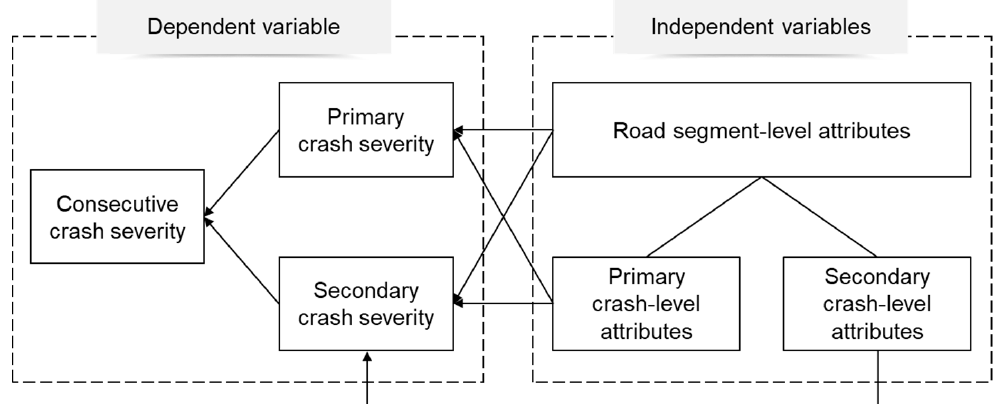
Figure 1. Conceptualization of the model structure for the severity of CC.